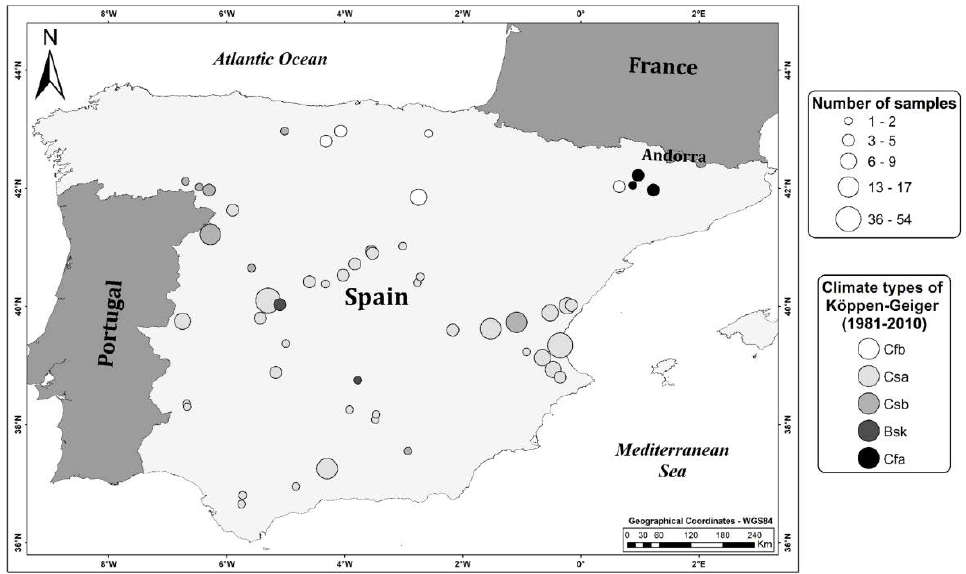
Figure 2. Location of sampled lakes and reservoirs. Symbol size reflects the number of samples collected at each site, and grayscale reflects the climate